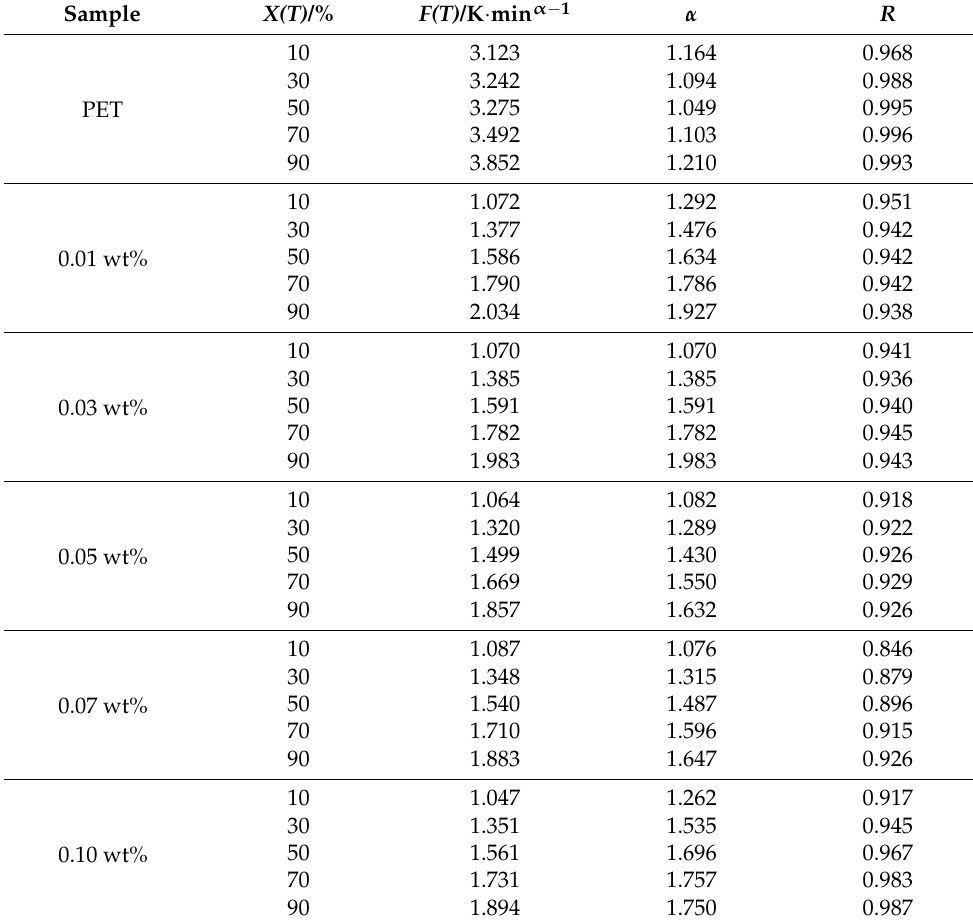
Table 4. Non-isothermal crystallization kinetics by the Mo